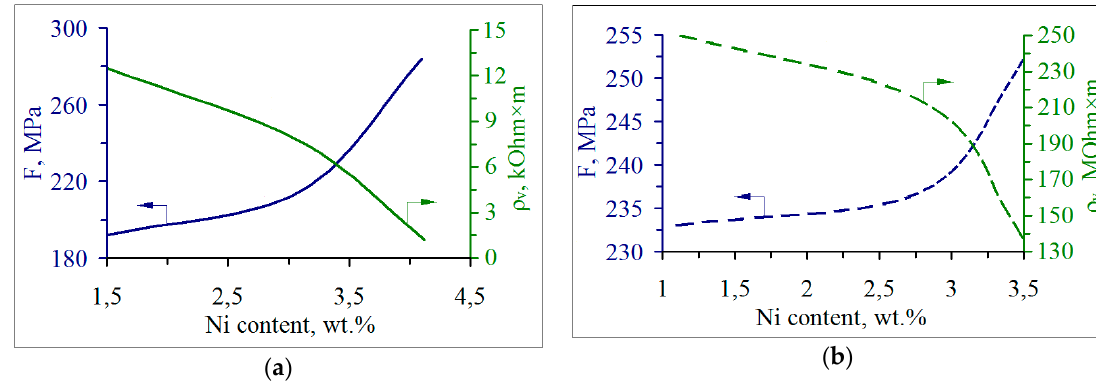
Figure 9. Effect of Ni(0) content on surface hardness (F) and specific volume electrical resistance ( ρ V ) of dry composites, obtained at pH 4 ( a ) and at pH 8 ( b ).